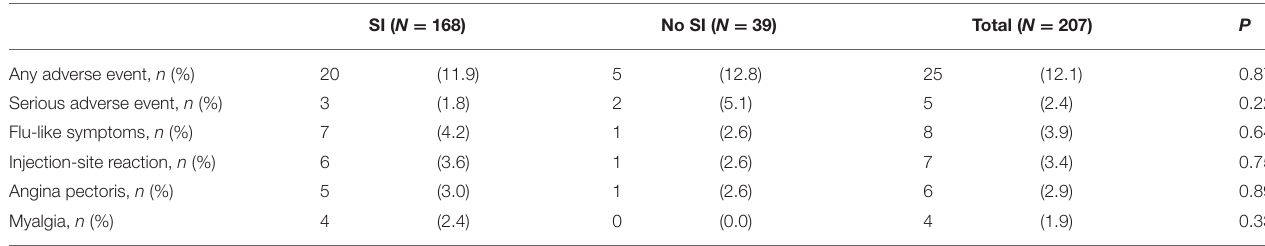
TABLE 3 | Adverse events according to the presence of statin